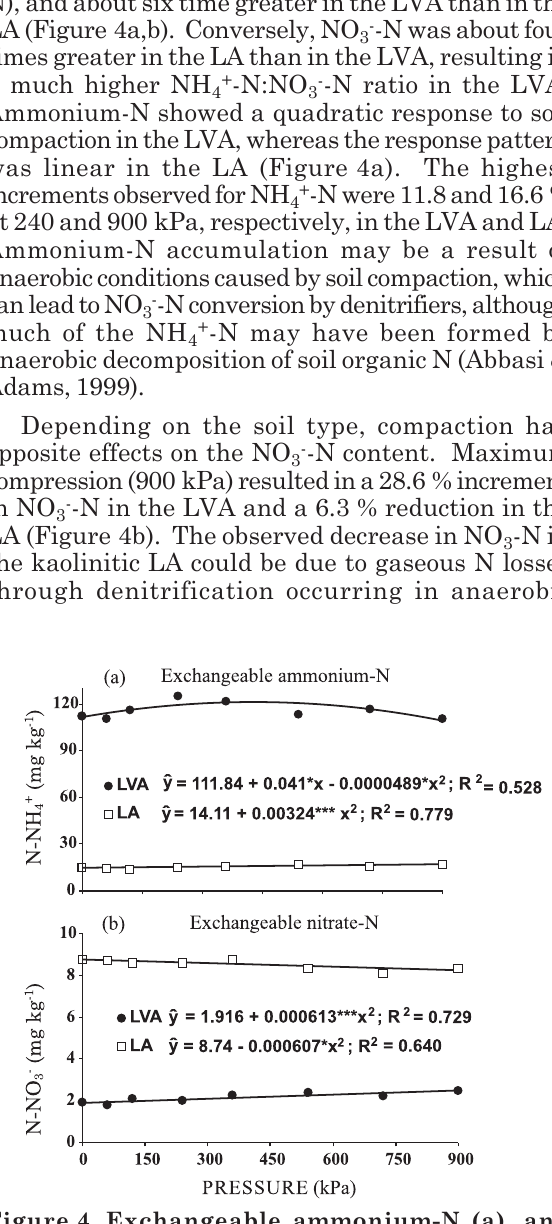
Figure 4. Exchangeable ammonium-N (a), and nitrate-N (b), in two Oxisols subjected to increasing compaction pressures. (***, **, *: significance of the coefficients by the F-test, respectively, at the level of 0.1, 1 and